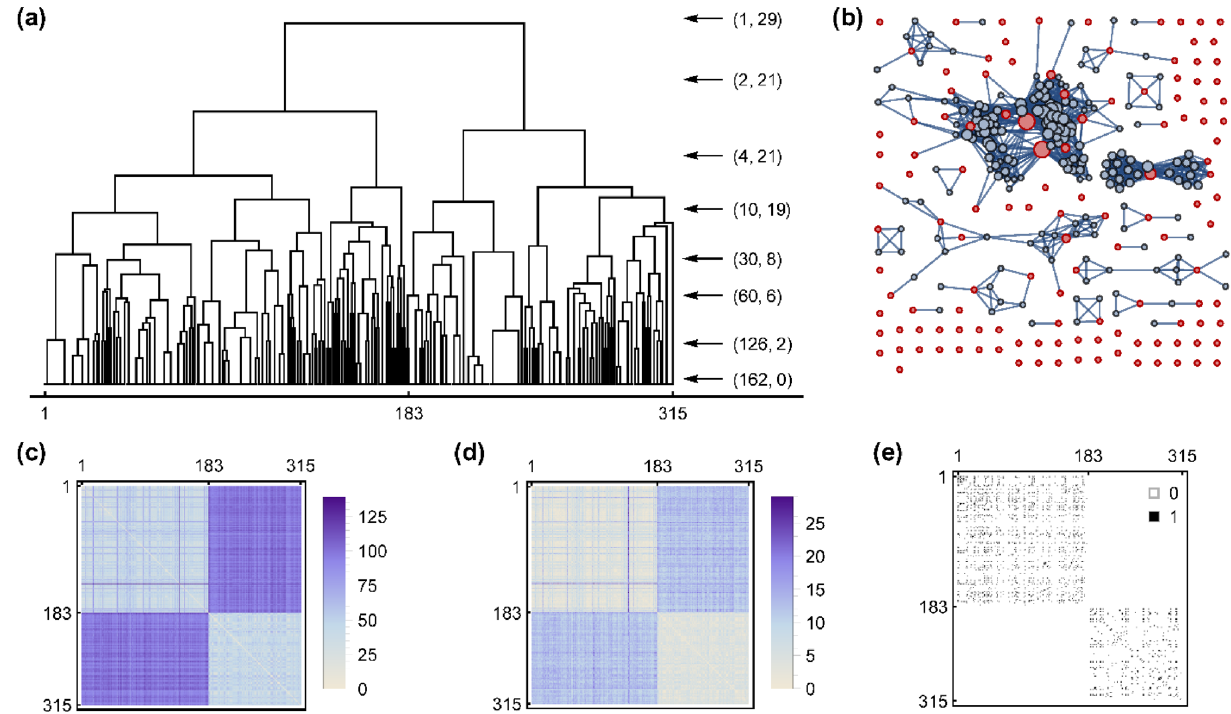
Figure 2. ( a ) Hierarchical clustering of curated receptor ensemble based on dissimilarity matrix N . For better presentation a logarithmic scale was used vertically. The arrows point to some possible levels of dendrogram truncation for which the first number in parenthesis is the number of clusters and the second one is the maximum intra-cluster dissimilarity. ( b ) Redundancy graph of curated receptor ensemble. Nodes are receptors scaled by their centrality and edges are redundancies ( N ij = 0 or A ij = 1 ). Red nodes are 126 members of non- redundant receptor ensemble selected via an iterative centrality-based procedure. ( c ) Dissimilarity matrix T . ( d ) Dissimilarity matrix N . ( e ) Adjacency matrix A . In all plots, the first 183 receptors are without